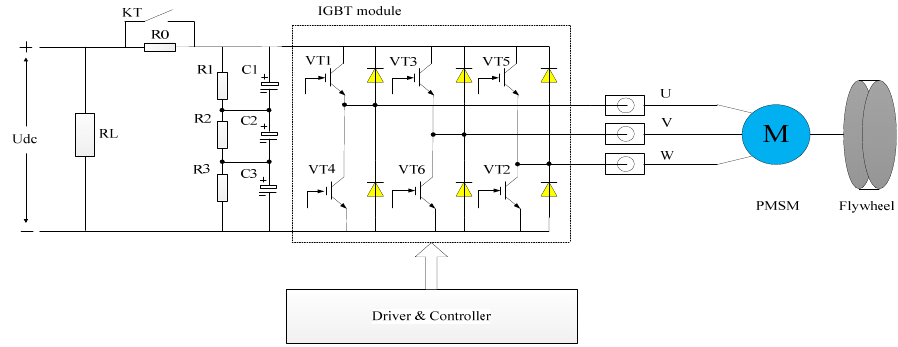
Figure 2. Minimum power scheme of permanent magnet synchronous motor (PMSM) driver. IGBT: insulated gate bipolar transistor.